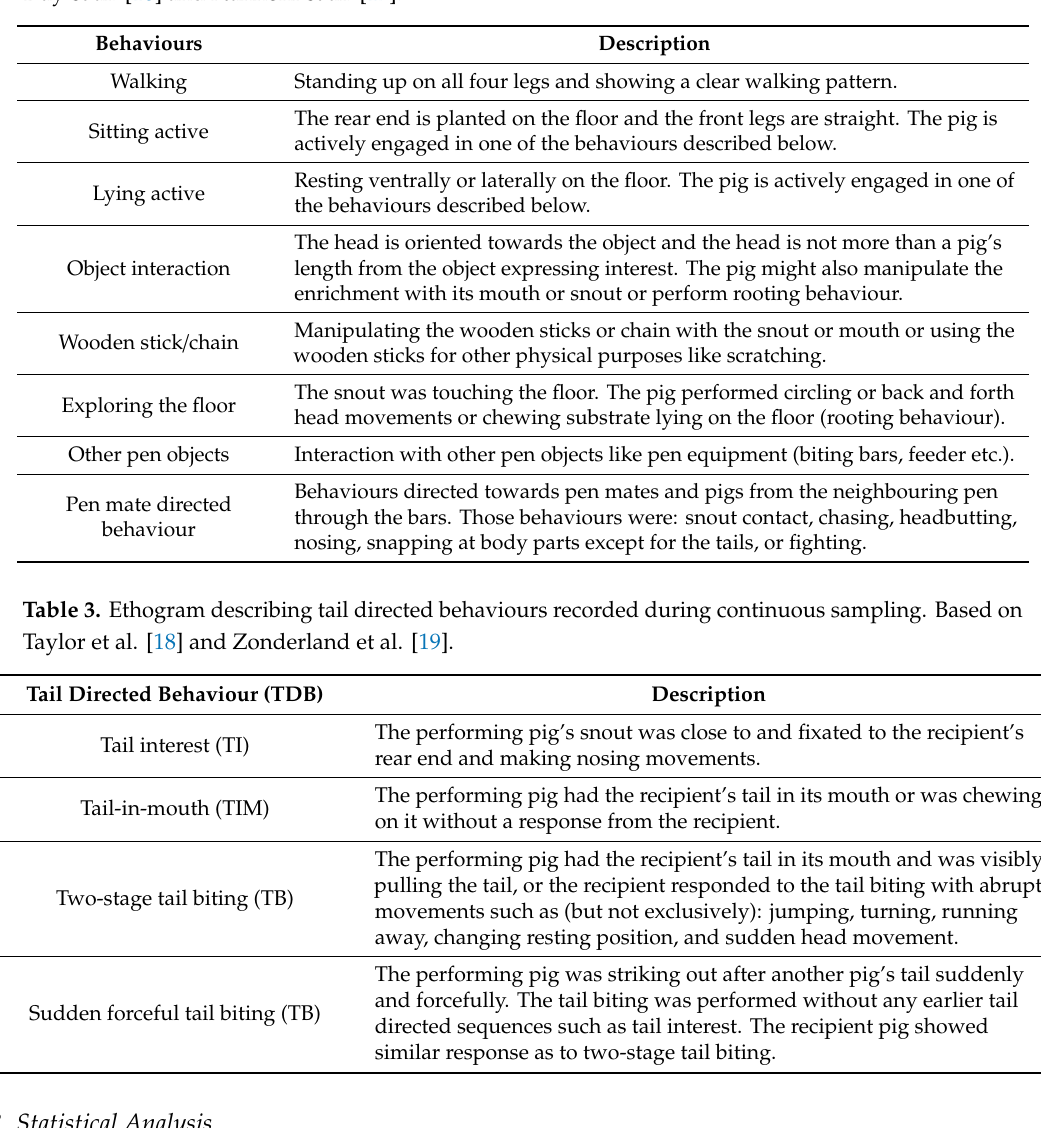
Table 2. Ethogram describing recorded pigs´ behaviours using scan sampling. Based on by Day et al. [16] and Nannoni et al. [17].